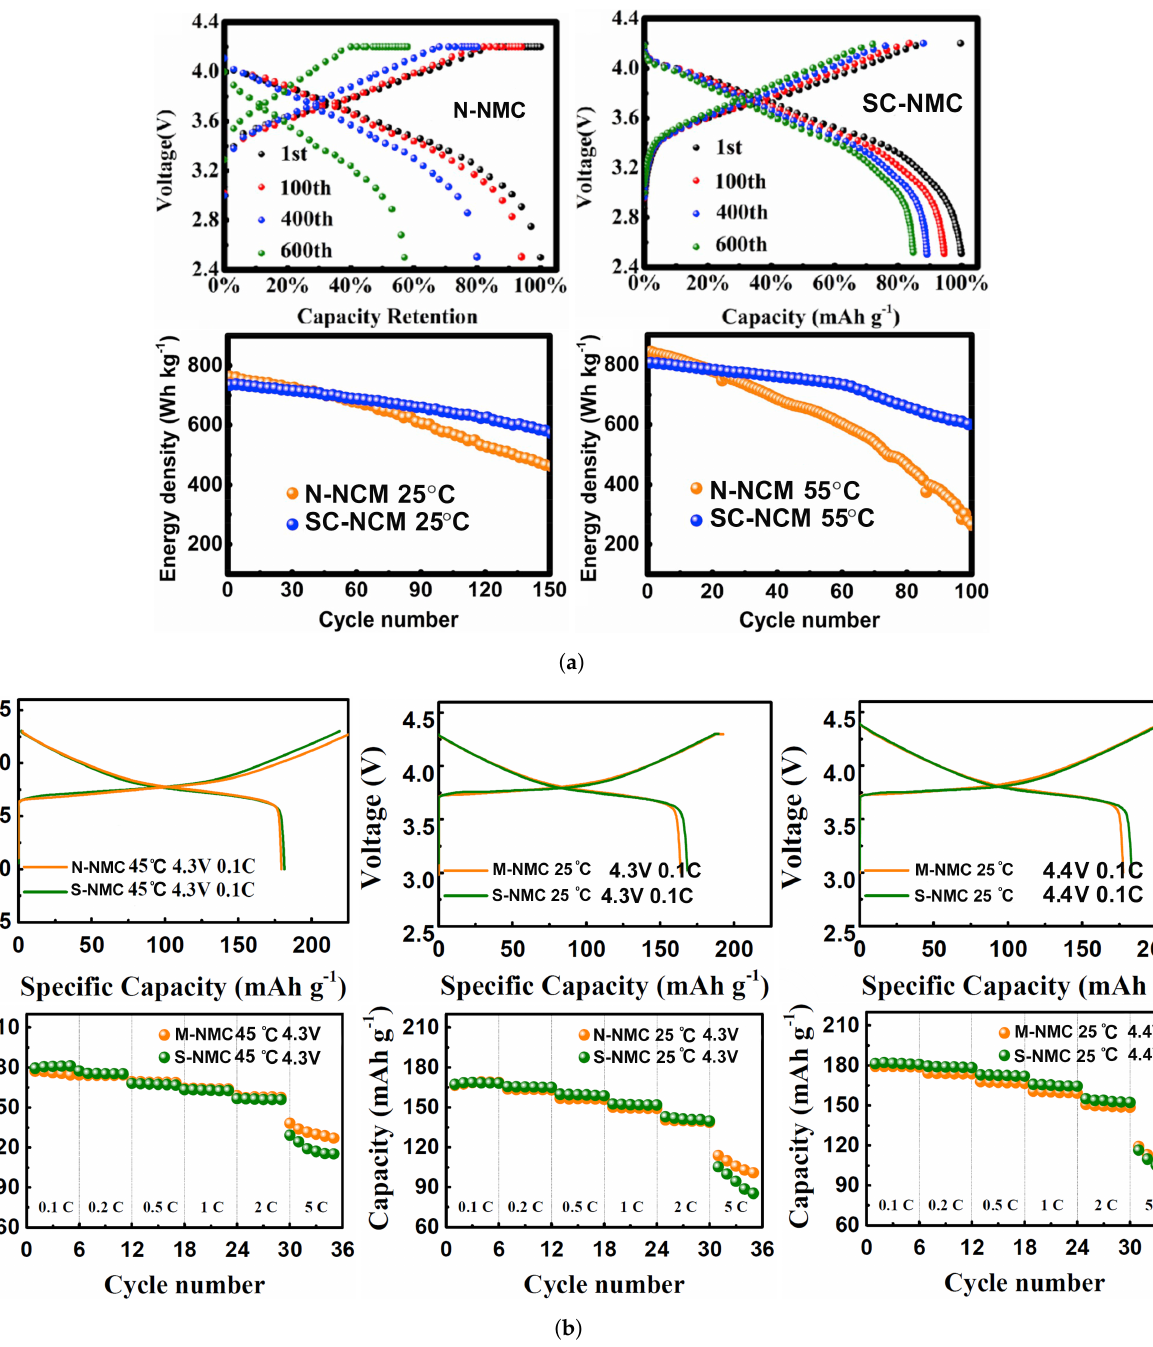
Figure 18. Electrochemical capability comparison between Single-Crystalline (SC-) and Normal (N-)/ Secondary (S-) and Monocrystalline (M-) NMC cathodes. ( a ) Charge/discharge curves and energy density at 0–100 cycle at 25 ◦ C and 55 ◦ C for a half-cell. Reproduced with permission [60]. ( b ) Charge/discharge curves and rate capacities for different temperatures and charging cut-off voltage for both S- and M- samples. Reproduced with permission